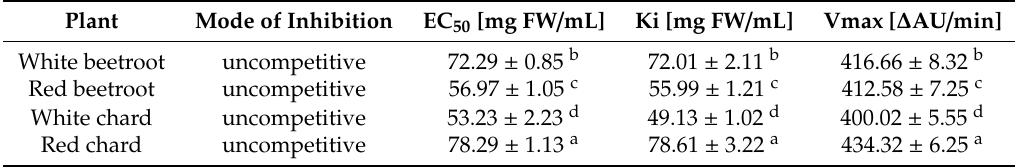
* The values are expressed as the mean ± SD; means with different letter superscripts (a–d) in the columns are significantly different ( α = 0.05).